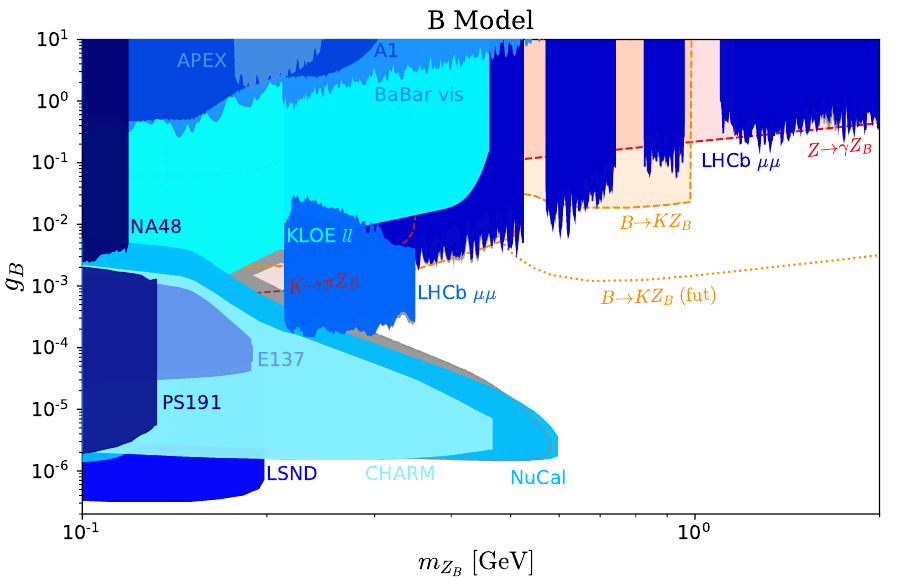
we obtained using data from B , K ± → B